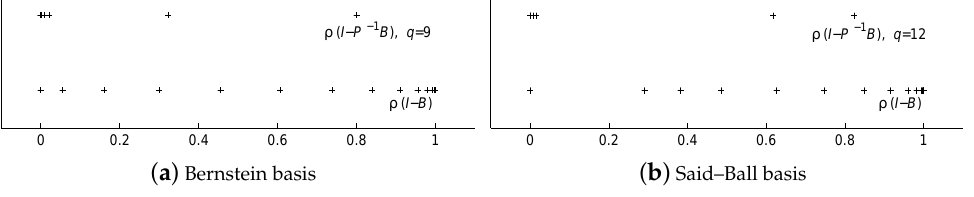
Figure 2. Spectral distributions of matrices I − B and I − P − 1 B in Example 2.